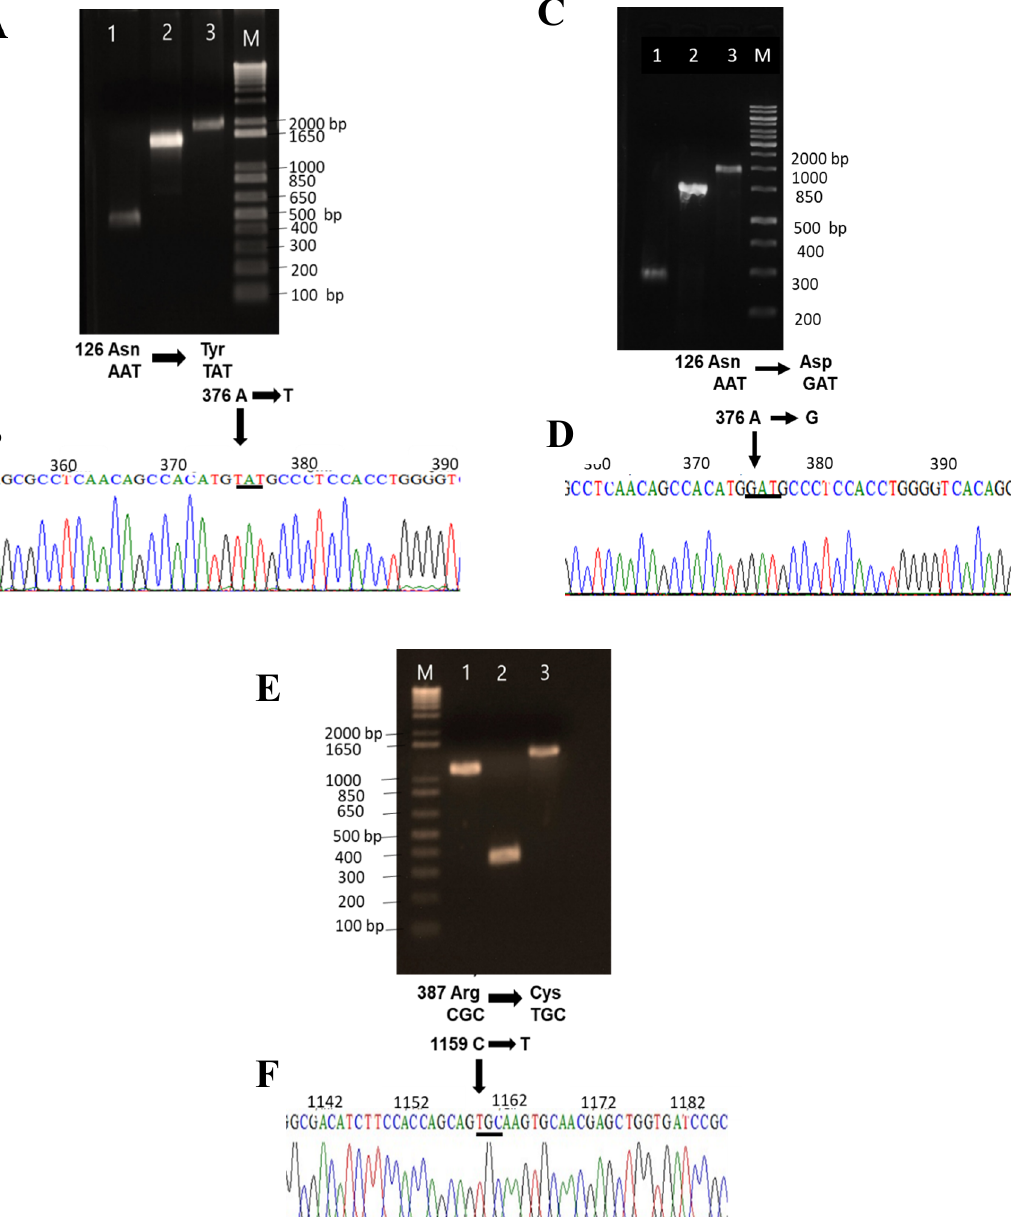
Figure 3. Site-directed mutagenesis for obtaining G6PD variants. ( A ) Amplicon resulting from polymerase chain reaction (PCR) in agarose gel electrophoresis (1%) for G6PD variant San Luis Potosi. Lanes 1 and 2. G6PD San Luis Potosi fragments. ( B ) Electropherogram of G6PD San Luis Potosi (A376, Asn → Tyr). ( C ) Variant G6PD A + . Lanes 1 and 2 G6PD A + fragments. ( D ) Electropherogram of G6PD A + (A376G, Asn → Asp). ( E ) Variant G6PD Guadalajara. Lanes 1 and 2 G6PD Guadalajara fragments. ( F ) Electropherogram of G6PD Guadalajara (C1159T, Arg → Cys). Line marked M in agarose gel electrophoresis corresponds to the Marker O’GeneRuler 1kb DNA ladder (Thermo Scientific) and line marked 3 corresponds to amplification of full-length